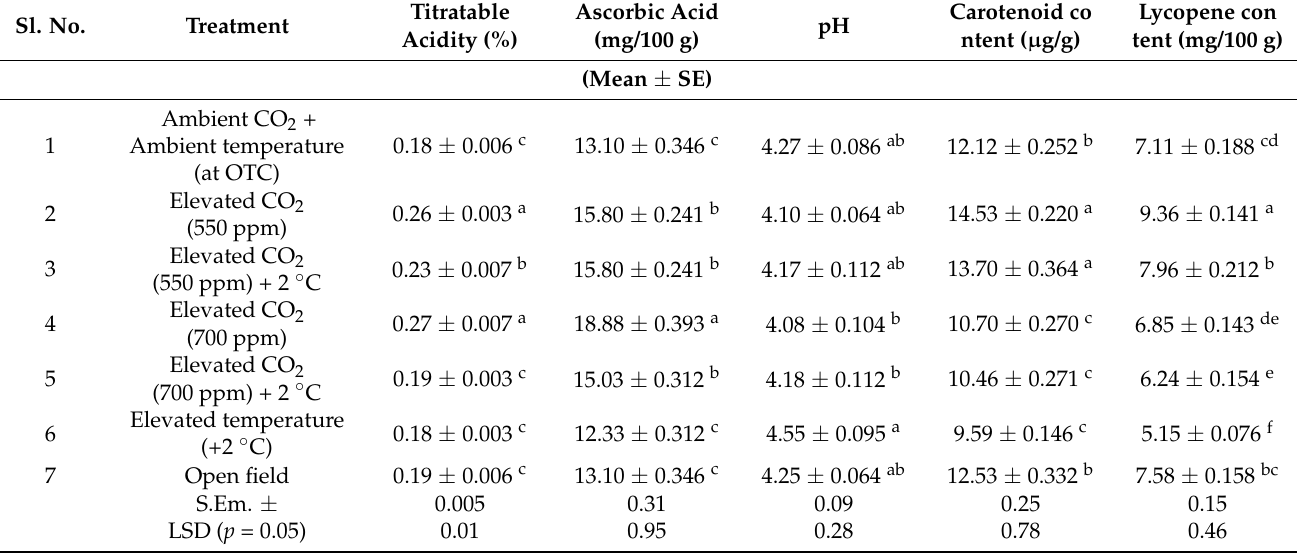
Table 4. Quality characteristics of tomato as influenced by elevated atmospheric CO 2 and temperature levels (cont.,). Sl. No.